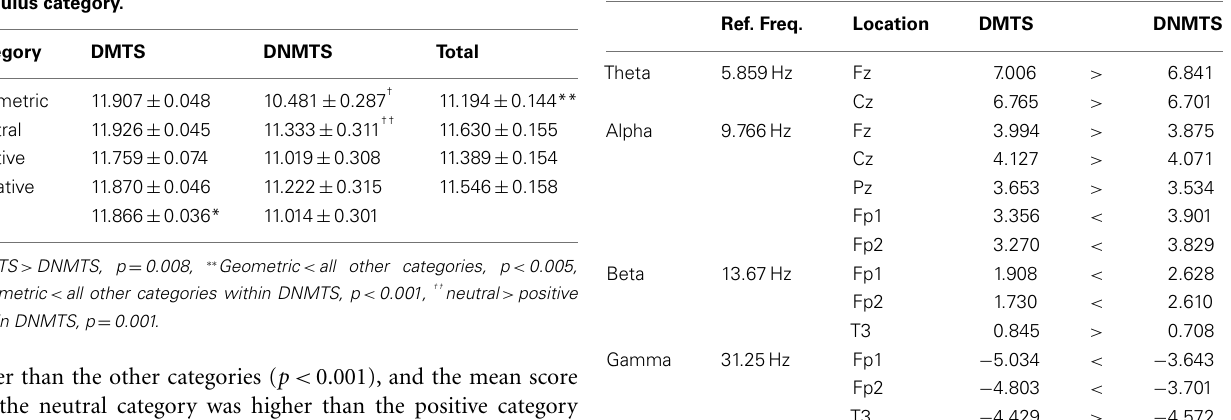
Table 2 | Mean spectrum power for each reference